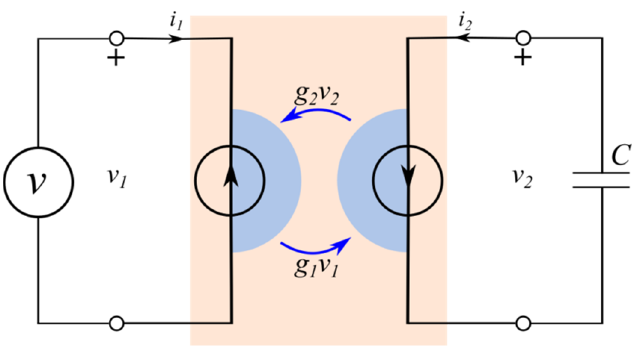
Figure 1. Gyrator: two-port passive electrical network element.